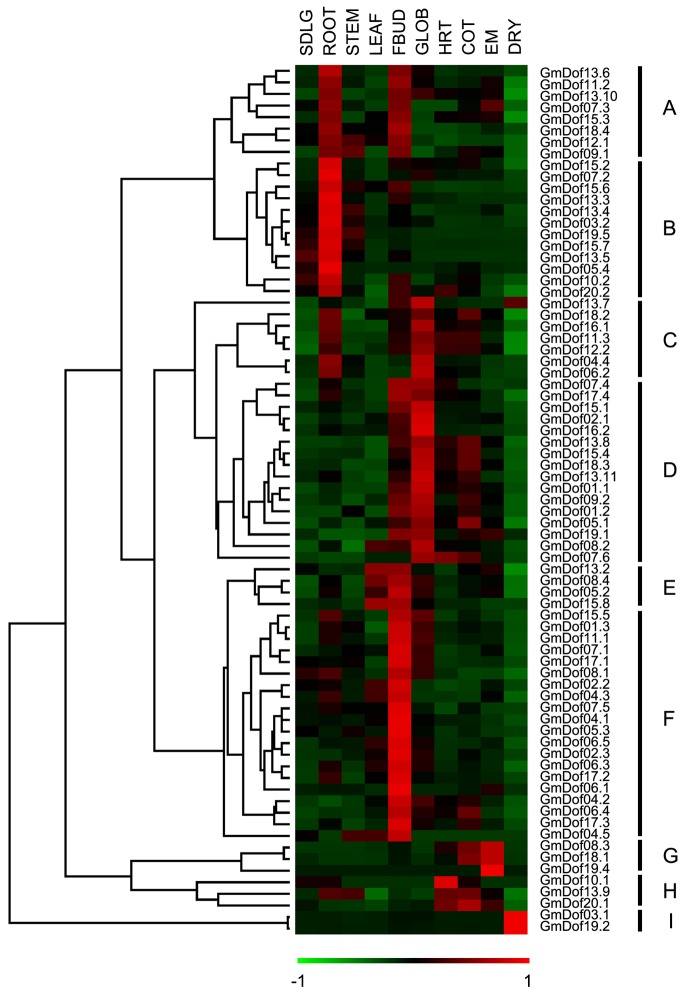
Heatmap of expression profiles for soybean Dof genes across different tissues.The genome-wide transcriptome data of soybean were generated from the NCBI database (accession numbers SRX062325–SRX062334). The expression data were gene-wise normalized and hierarchically clustered. The relative expression level of a particular gene in each row was normalized against the mean value. The color scale below represents expression values, green indicating low levels and red indicating high levels of transcript abundance. The sources of the samples were as follows: SDLG (whole seedlings 6 days after imbibition), LEAF (leaves), ROOT (roots), STEM (stems), FBUD (floral buds), GLOB (globular-stage embryos), HRT (heart-stage embryos), COT (cotyledon-stage embryos), EM (early maturation stage embryos), and DRY (dry soybean seeds).